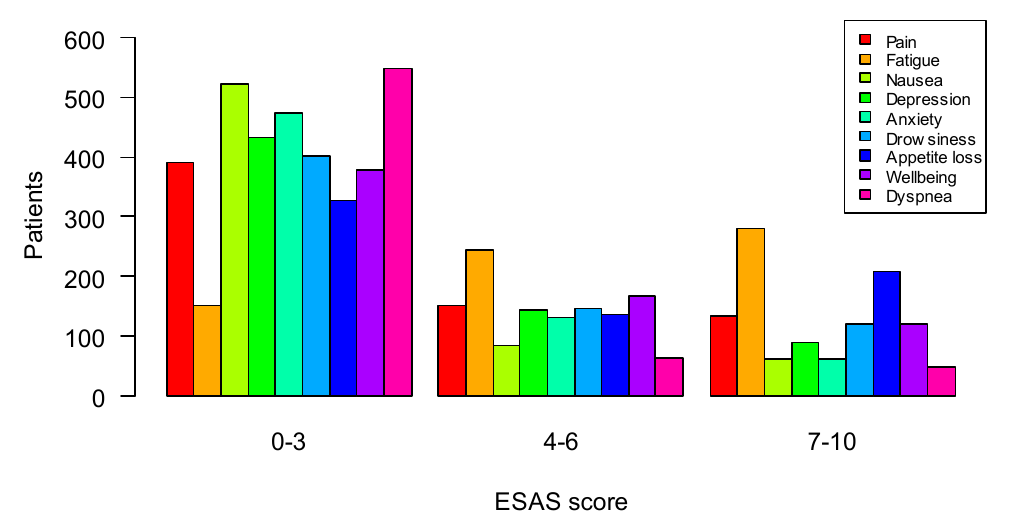
Figure A2. Comparison of symptoms recorded in referral form and during SCOC visit.